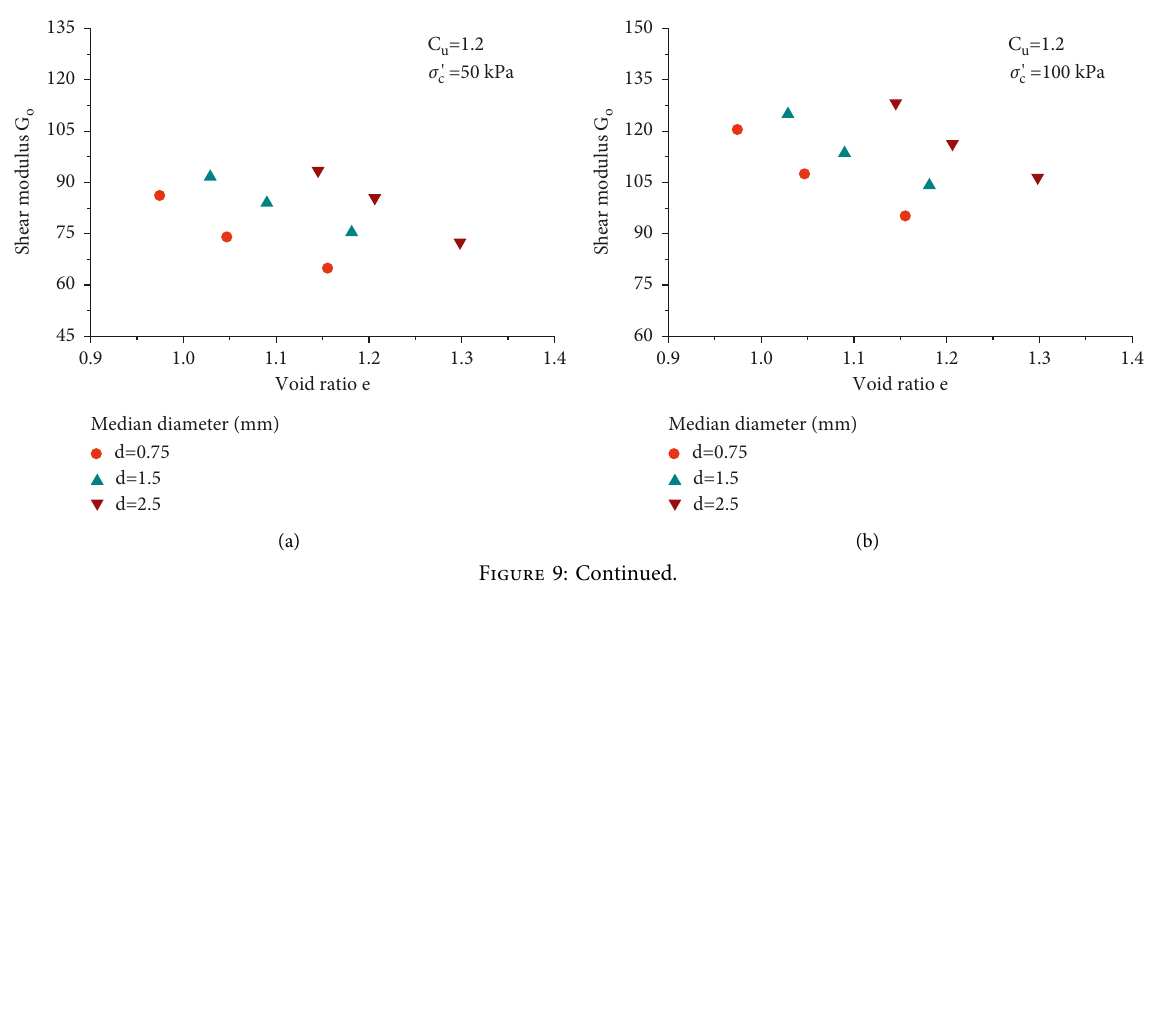
� 0.75mm, 100kPa; 50